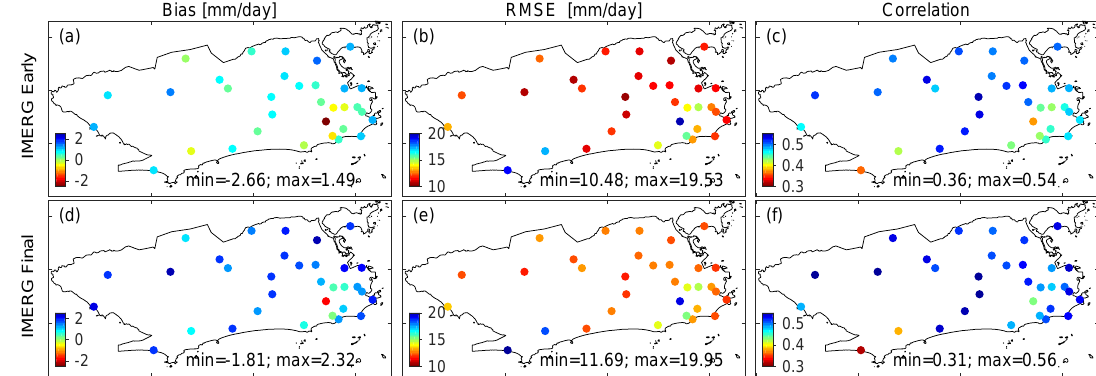
Figure 2. Daily bias, root mean square error (RMSE) and correlation for IMERG Early ( a – c ) and IMERG Final ( d – f ) at 33 pluviometric stations for 2001–2019 wet seasons (November-April). Limits of Rio de Janeiro city are defined by the black